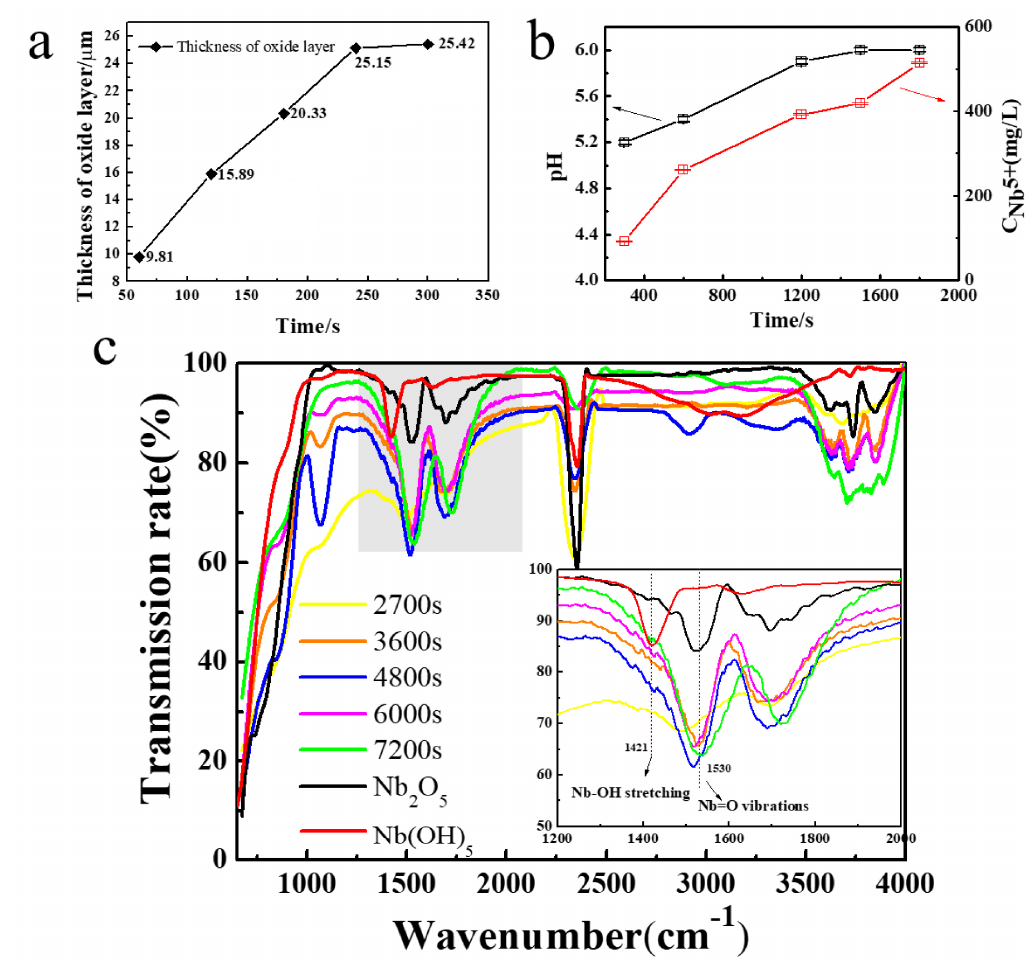
Figure 4. ( a ) Growth patterns for oxide layer thickness and anodic oxidation time in stage II. ( b ) Trend chart of pH and Nb 5 + concentration of electrolyte in stage III. ( c ) ATR-IR spectra of Nb 2 O 5 NAs. Experimental conditions: 0.4 M NH 4 F electrolyte containing glycol electrolyte at 20